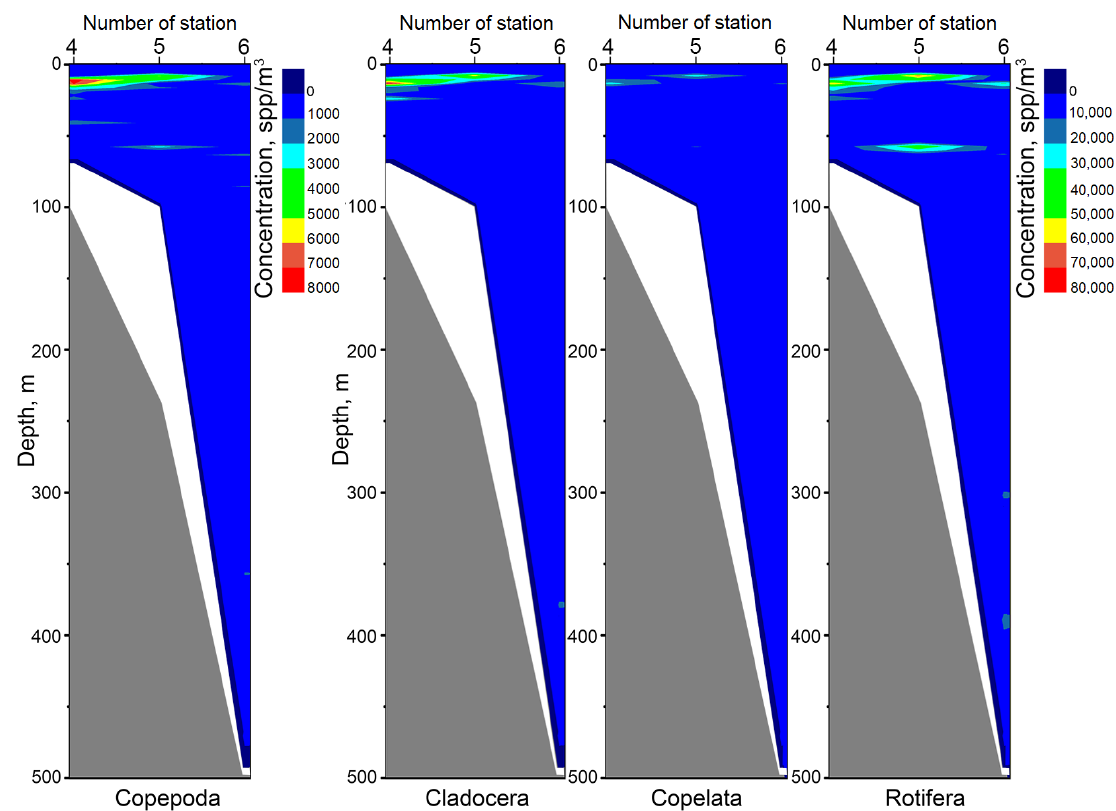
Figure 10. Average concentration profiles of particles related to four taxa (Copepoda, Cladocera, Copelata, Rotifera) over depth, measured by the miniDHC in forward motion (submersion) at stations: No. 4 (coordinates 044°32.1922 ′ N 37°56.0360 ′ E; submersion 0 up to 70 m), no. 5 (44°32.0743 ′ N 37°55.3762 ′ E; up to 100 m), no. 6 (44°31.2398 ′ N 37°54.3828 ′ E; up to 500 m). Gray shows the seabed profile, white (the absence of data (registration at this depth was not made). The right concentration scale refers to the graphs of Cladocera, Copelata, and Rotifera taxa, the left scale refers to Copepoda taxon.